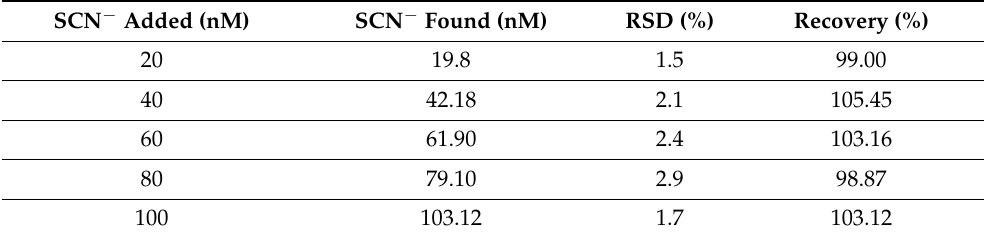
Table 1. Precision (RSD%) and percentage of recovery in the present study.